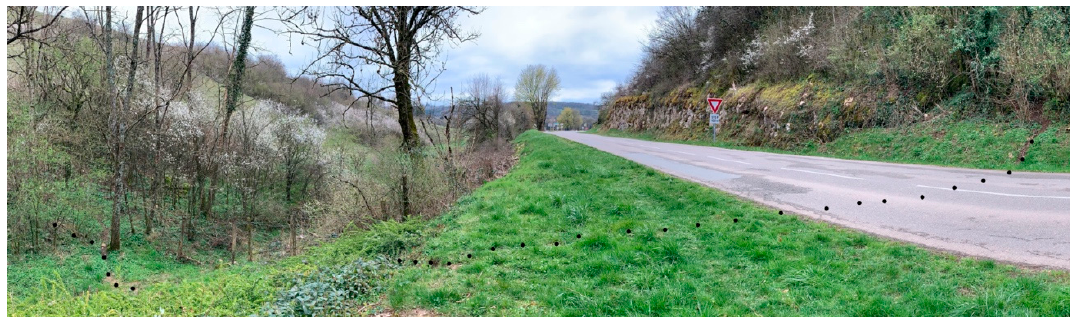
Figure 13. The intersection between a paved road and a trackway made by a wild animal near Pugey (France), source L. Nuninger.